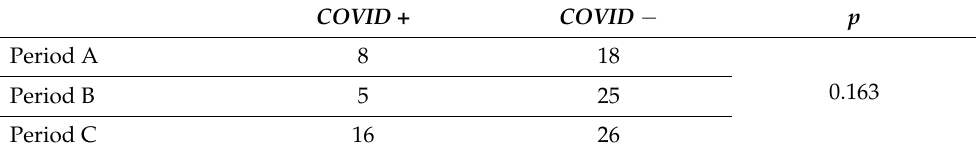
Table 6. Number of co-infections with Enterococcus spp. and SARS-CoV-2 during this study. COVID + COVID − p Period A 8